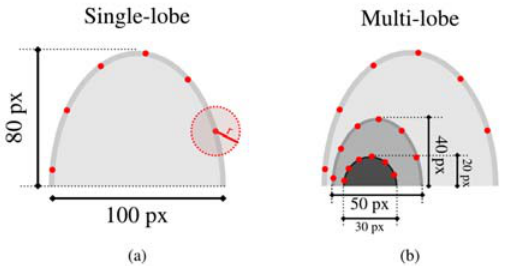
Figure 2. Sensitivity analysis with simulated data. Schematic depiction of the two simulated landslide scenarios: ( a ) single-lobe (semi-ellipse) and ( b ) multi-lobe (three nested semi-ellipses). The red dots identify the location of the demodulation patches (of radius r ).